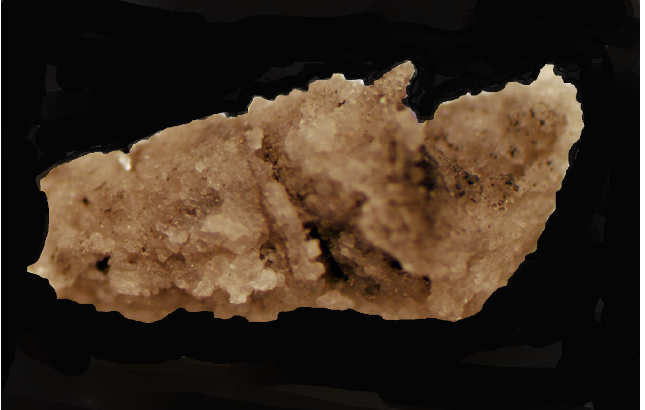
Figure 7. Abyssochrysoid gastropod. Silicified specimen from acid maceration. Note varix-like axial ribs. Field sample 12 of 23 May 2014, IGM 5010b, Late Triassic, Norian Stage ( Tropites welleri - Stikinoceras kerri zones), Shaly Limestone Member of the Luning Formation, Nye County, Nevada. Greatest dimension of preserved shell: 4.0 mm.